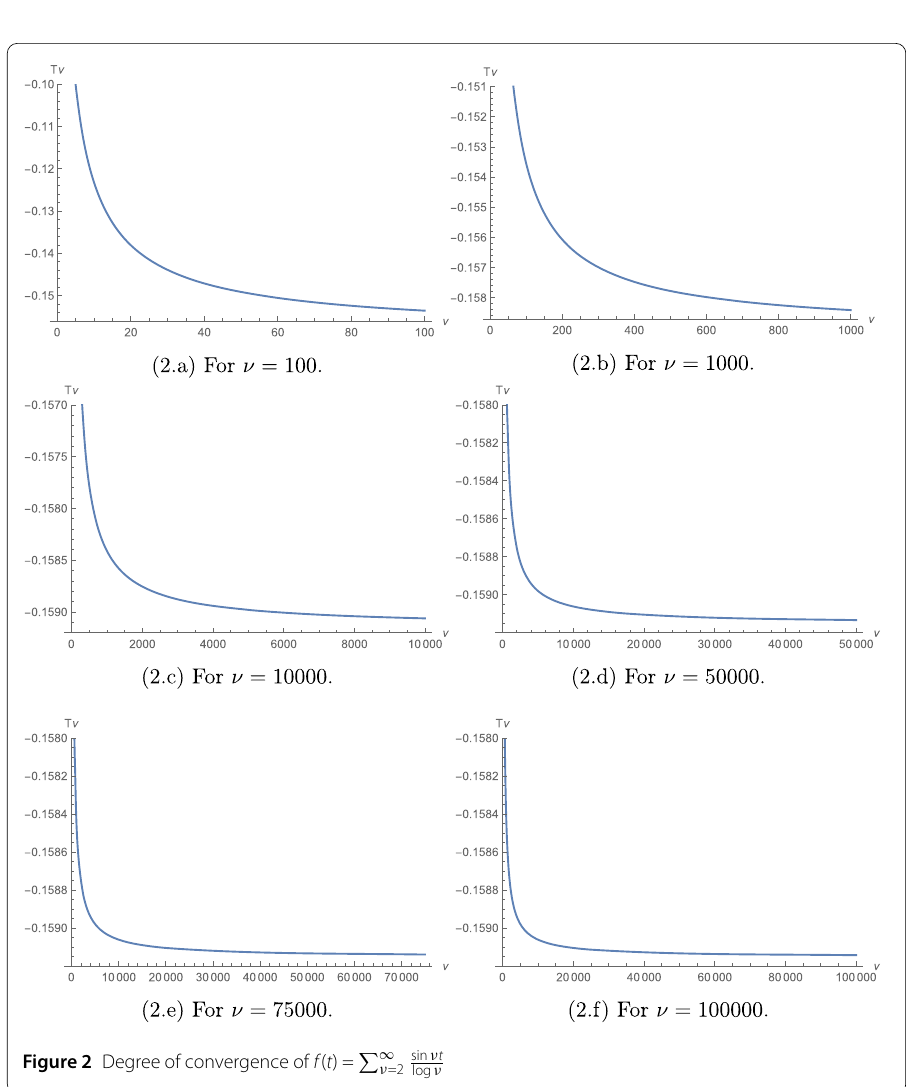
(cid:18) ∞ sin ν t ν =2 log